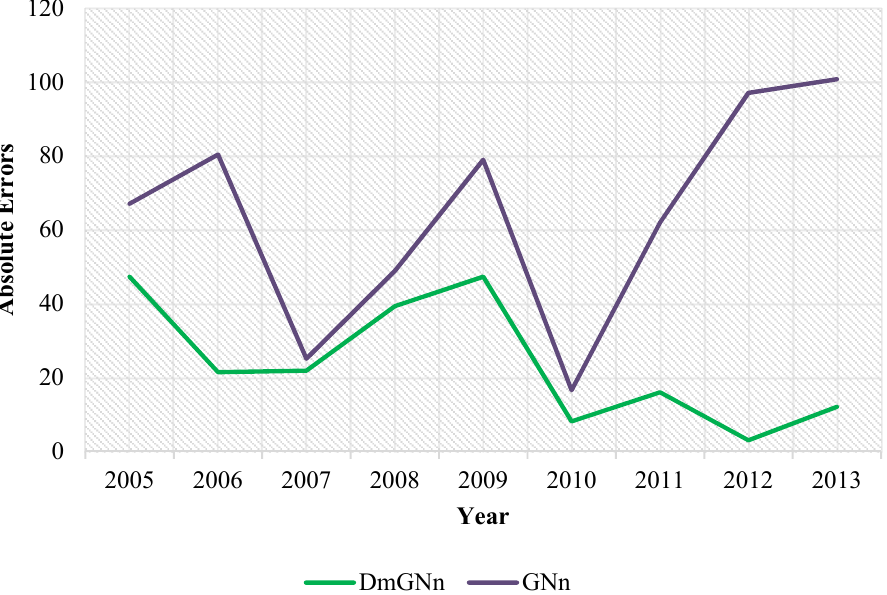
Figure 9. Absolute error for each different input protocols along the testing period.